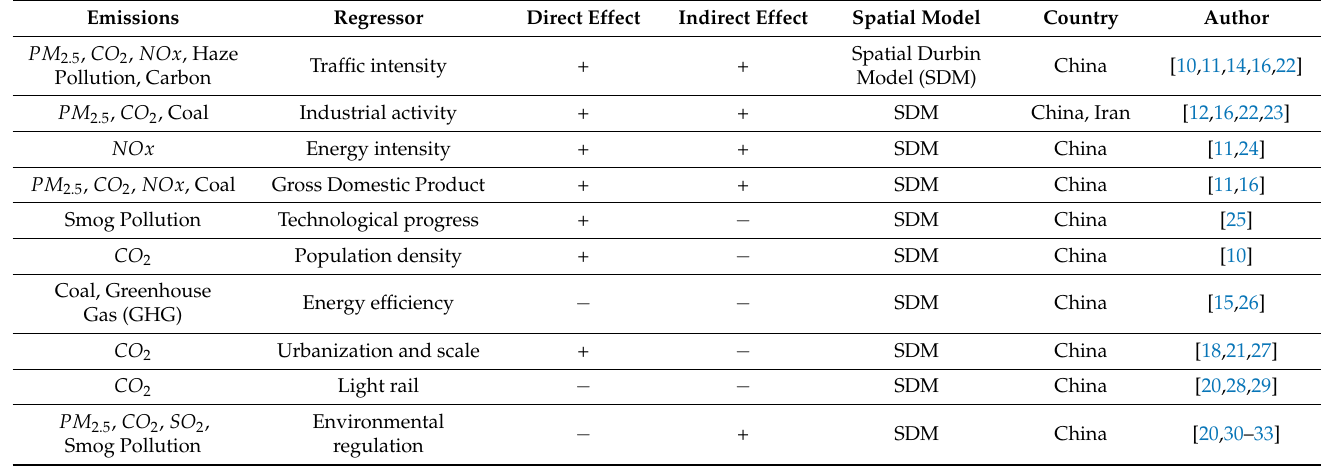
Table 1. Studies on spatial spillover effects of pollutant gas